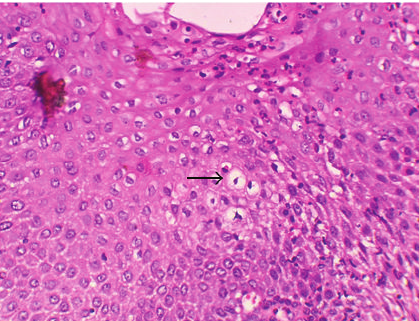
Figure9:Highpowerphotomicrographofthelesiondemonstrating koilocytes (arrows) in the spinous layer (H&E,